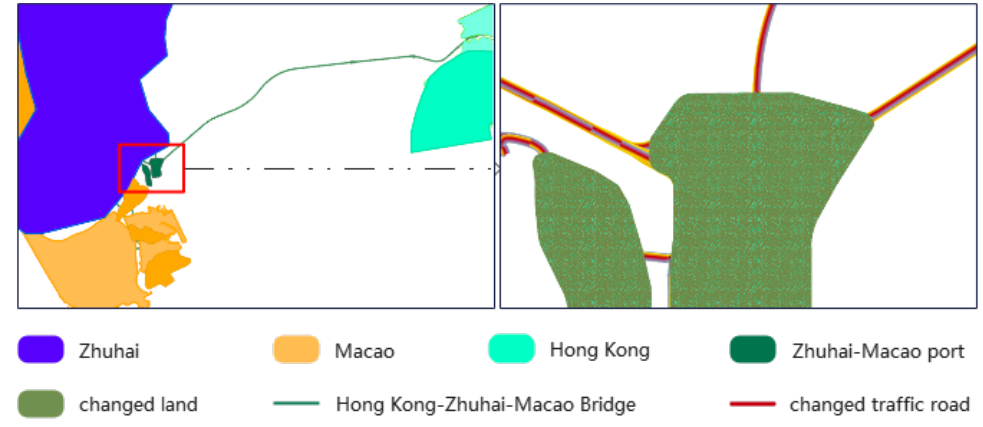
Figure 12. The mapping of the study